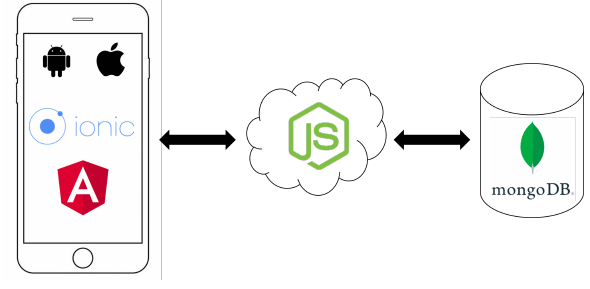
Figure 6: High-level three-tiear system